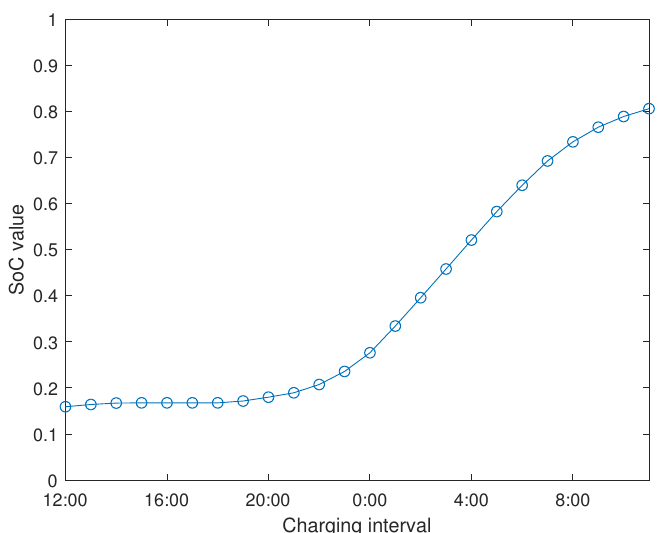
Figure 8. Evolution of the PEV’s SoC for Algorithm 3 under replay attack or random attack.